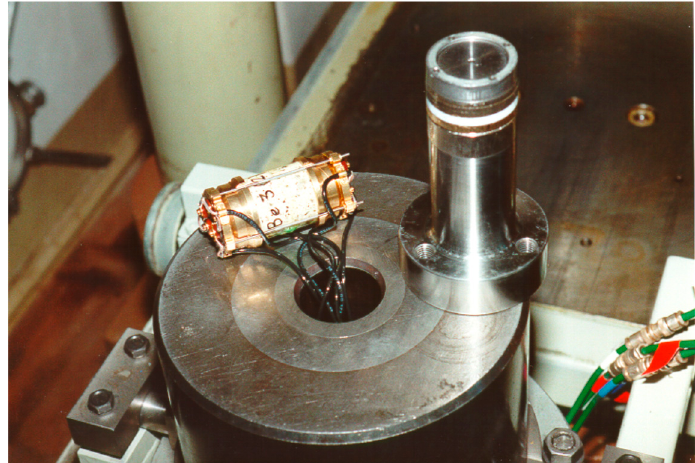
Figure 7. Internal set-up of the 0.5 GPa oil pressure chamber.